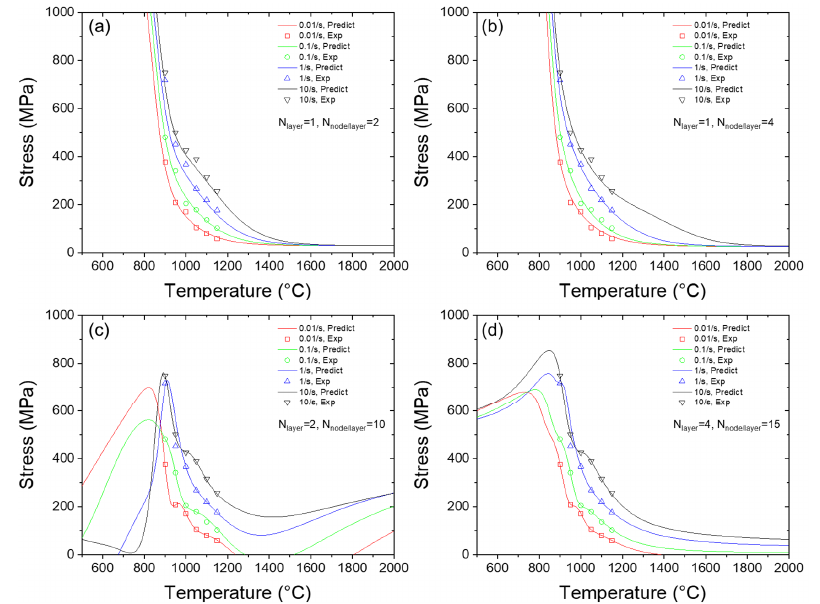
Figure 6. Predicted temperature dependency of fl ow stress using ANNs with di ff erent structures. ( a – d ) are the predicted stress-temperature curves by using ANNs with 1 × 2, 1 × 4, 2 × 10, 4 × 15